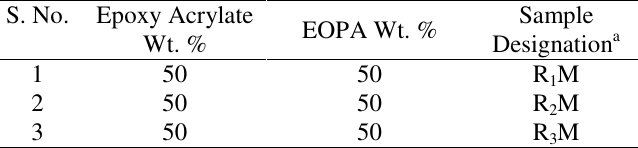
Table 1. Sample designation of various blends sample